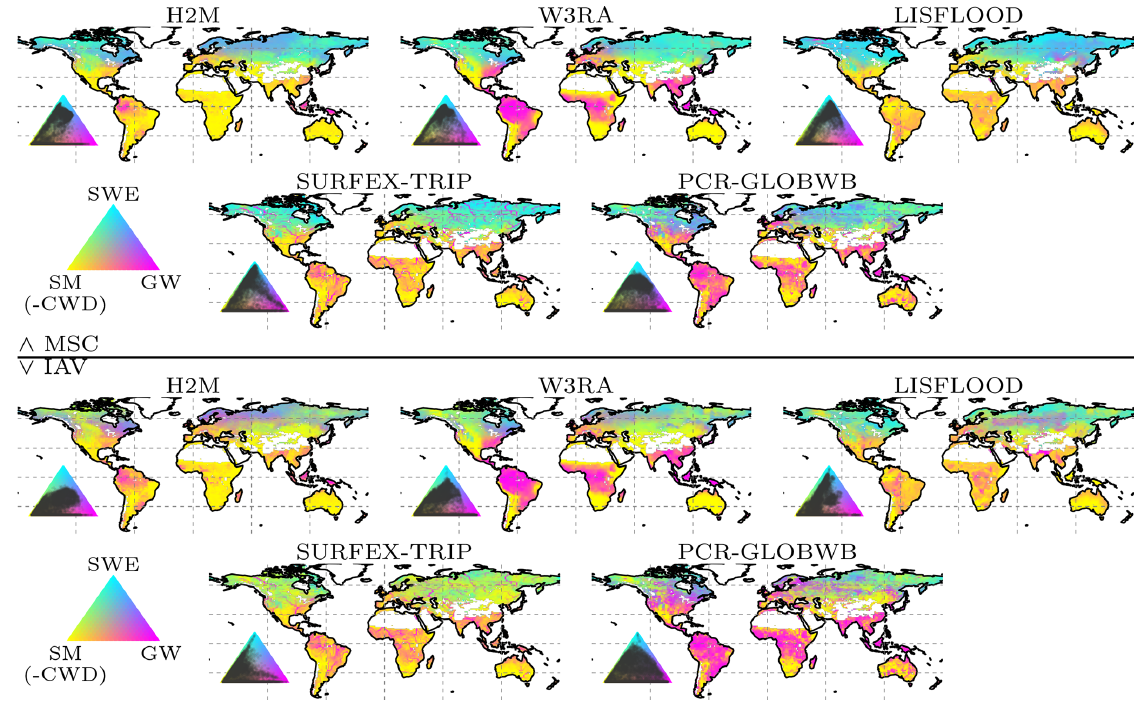
Figure 8. Terrestrial water storage (TWS) variation partitioning into soil moisture (SM, corresponding to negative modeled cumulative water deficit, CWD), groundwater (GW), and snow water equivalent (SWE) by the hybrid hydrological model (H2M) and a set of process-based global hydrological models (GHMs). The top panel shows the partitioning of the mean seasonal cycle (MSC), and the bottom panel shows the interannual variability (IAV). The map colors correspond to the mixture of the contributions of the three variables, and the inset ternary plots reflect the density of the map points projected onto the components. The contribution is calculated as the sum of the bias-removed absolute deviance of a component from the mean, divided by the contribution of all components. Note that surface storage is included in the groundwater component for the models SURFEX-TRIP and PCR-GLOBWB. The decomposition is done based on the years 2003 to